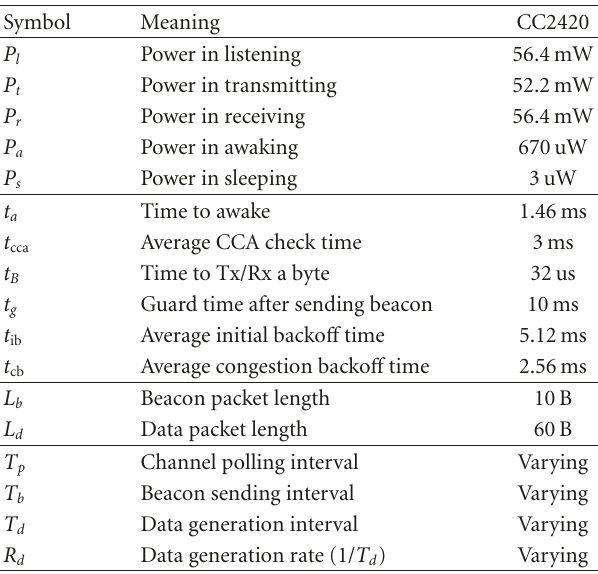
Table 1: Typical power and measured time values for Telosb 802.15.4 CC2420 radio and CSMA/CA, and symbols used in